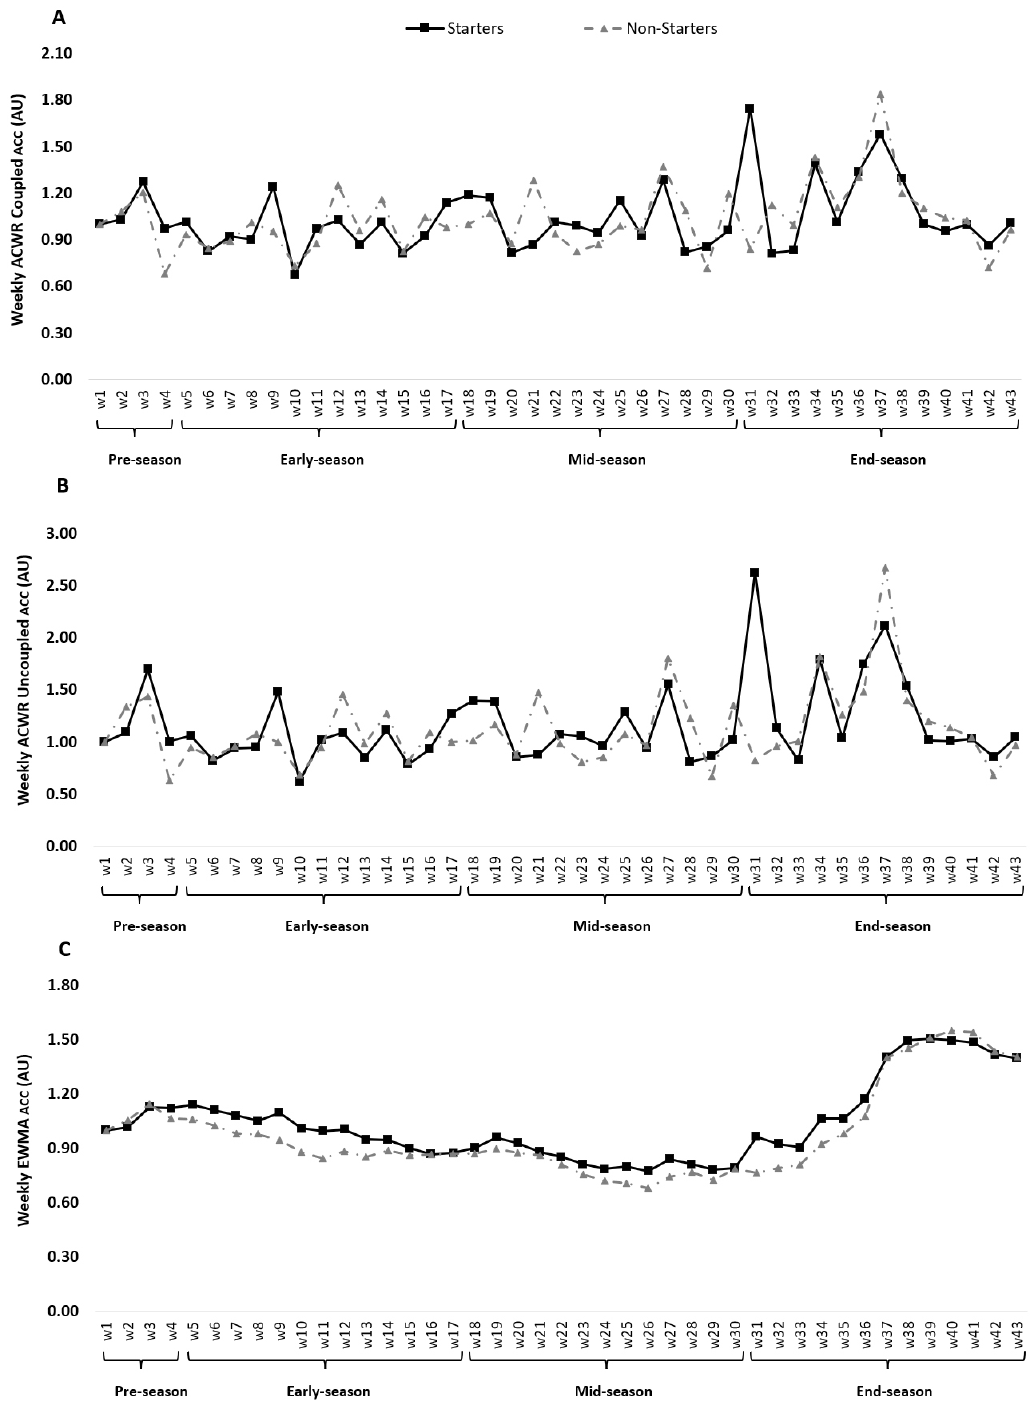
Fig. 3. ACWR coupled (A), ACWR uncoupled (B), and EWMA (C) variations calculated based on Acc across 43 weeks for starters and